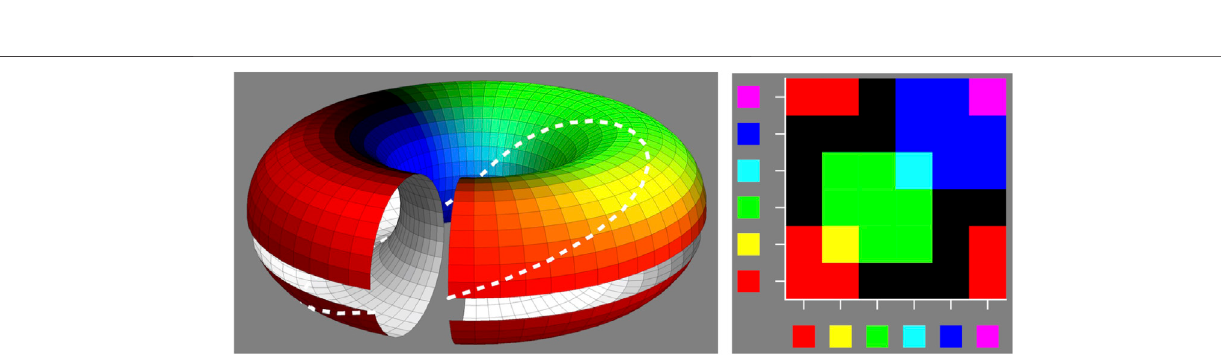
topologyishardlyintuitive[Whatpeopleroot-learnatelementaryschoolis “ blue(actuallycyan)andyellowyieldsgreen, ” andsoforth.]Forinstance,atright,likethegreen, the red is also a full square. The right fi gure shows the parameter plane. Both coordinates run over the circle (0 − 2 π , that is red to red). Thus the left side is connected to the right side and the bottom to the top.